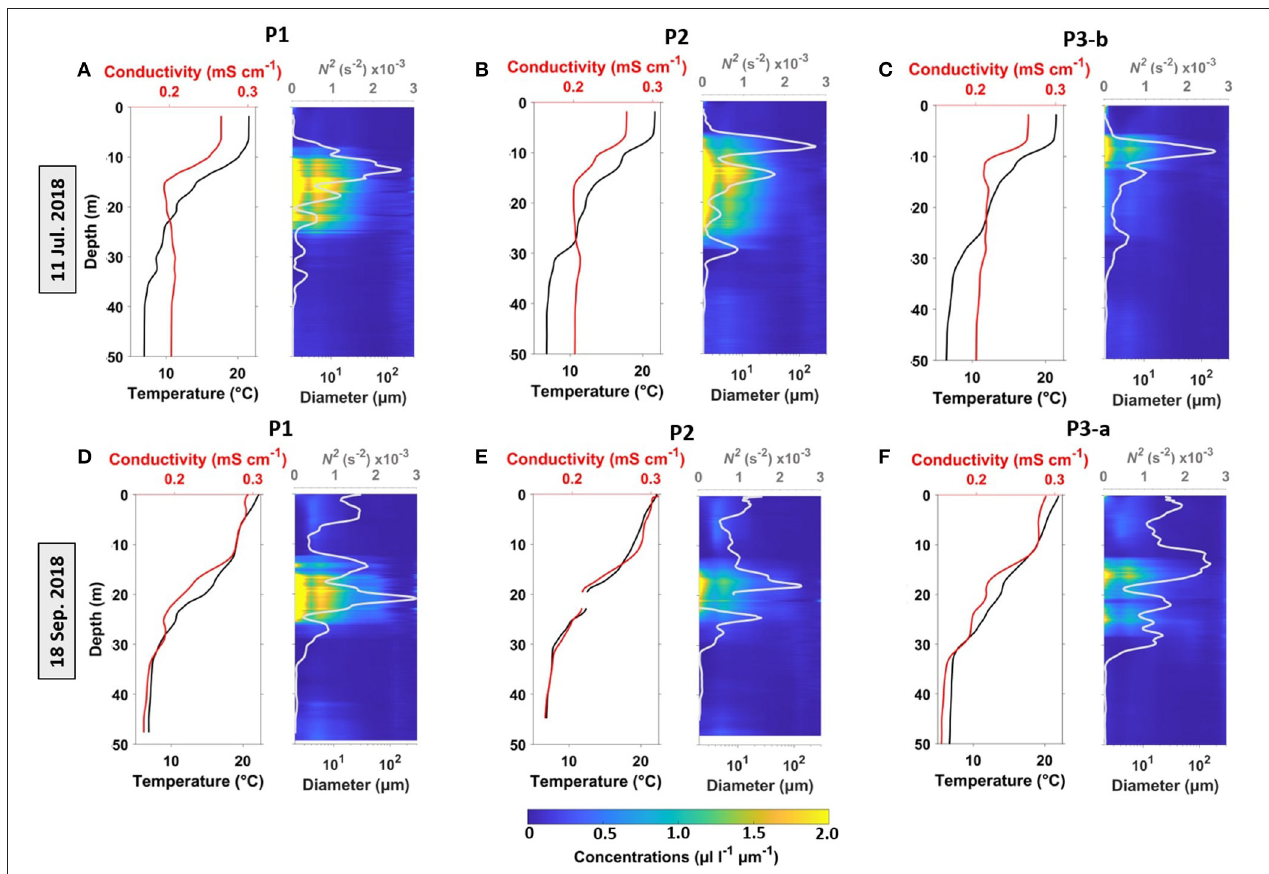
FIGURE 2 | Temperature profiles (black lines), electrical conductivity at 25 ◦ C (red lines) and N 2 profiles (white lines) plotted over concentration of particles per size class (color maps; from LISST) at stations P1, P2, P3-a, and P3-b. Top panels (A–C) 11 July 2018; bottom panels (D–F) 18 September 2018. Note the different ordinate axis values (depths) for P2 and P3. For station locations, (see Figure 1B ). The colorbar gives the (volume) particle concentration per size class ( µ l l − 1 µ m − 1